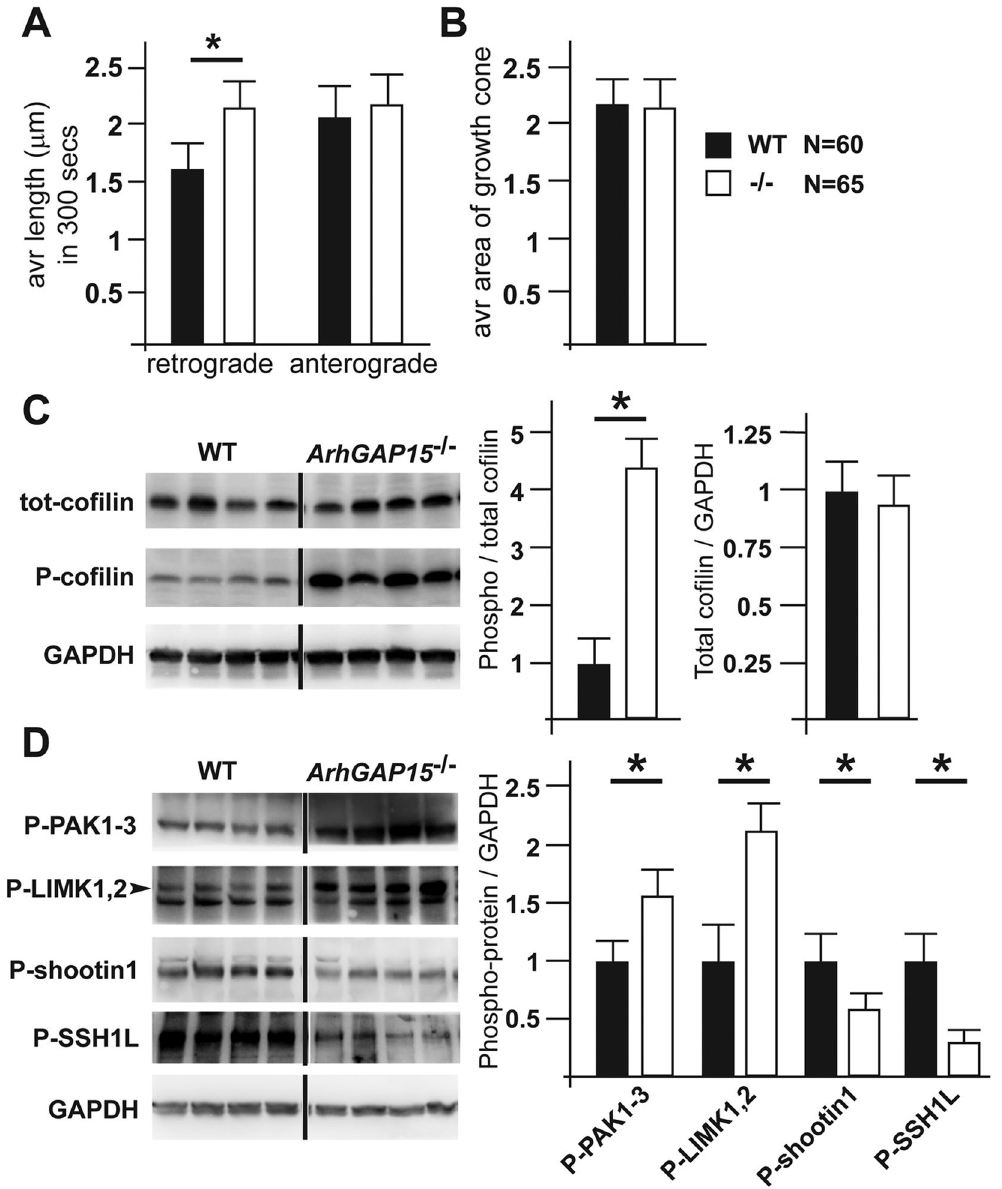
Figure 5. Loss of ArhGAP15 alters actin dynamics at the axonal growth cone, associated to increased activity of the PAK-LIMK-ADF/Cofilin pathway. ( A ) Quantification of retrograde and anterograde actin filament extension in neurons dissociated from WT or ArhGAP15 − / − cortices, at E15.5. While anterograde extension is unchanged, in the absence of ArhGAP15 retrograde actin extension is increased. ( B ) Quantification of the area of the growth cones. The average area is unchanged. N corresponds to the number of neurons analyzed for, respectively, the WT and ArhGAP15 mutant genotypes, from at least three independent cell cultures. ( C ) Western blot analyses of ADF/cofilin and phospho-ADF/cofilin in total extracts of WT and ArhGAP15 − / − cortices, at P2. The signal relative to GAPDH is used as loading control and subsequent normalization. On the right, quantification of the ratio of phospho-ADF/cofilin over the amount of total ADF/cofilin and phospho- ADF/cofilin, corrected for GAPDH expression. The WT is placed = 1. ( D ) Western blot analyses of phospho- PAK1-3, phospho-LIMK1/2, phospho-SSHL1 and phospho-shootin1 in total extracts of WT and ArhGAP15 − / − cortices, at P2. The signal relative to GAPDH is used as loading control and subsequent normalization. On the right, quantification of the ratio of phospho-PAK1-3, phospho-LIMK1/2, phospho-SSHL1 and phospho- shootin1 corrected for GAPDH expression. The WT is considered = 1. Full-length blots are presented in Supplementary Figure S4. Data are presented as mean ± SEM. * P ≤ 0.05 (Student’s